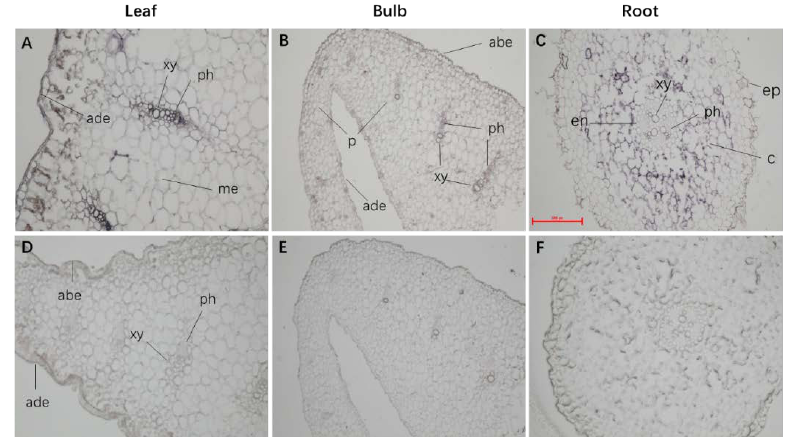
Figure 4. In situ hybridization of LaABCB11 in different tissues of L. aurea . ( A ) Hybridizations using a digoxigenin-labeled anti-sense probe in the cross-sections of leaves, ( B ) bulbs, and ( C ) roots. ( D –